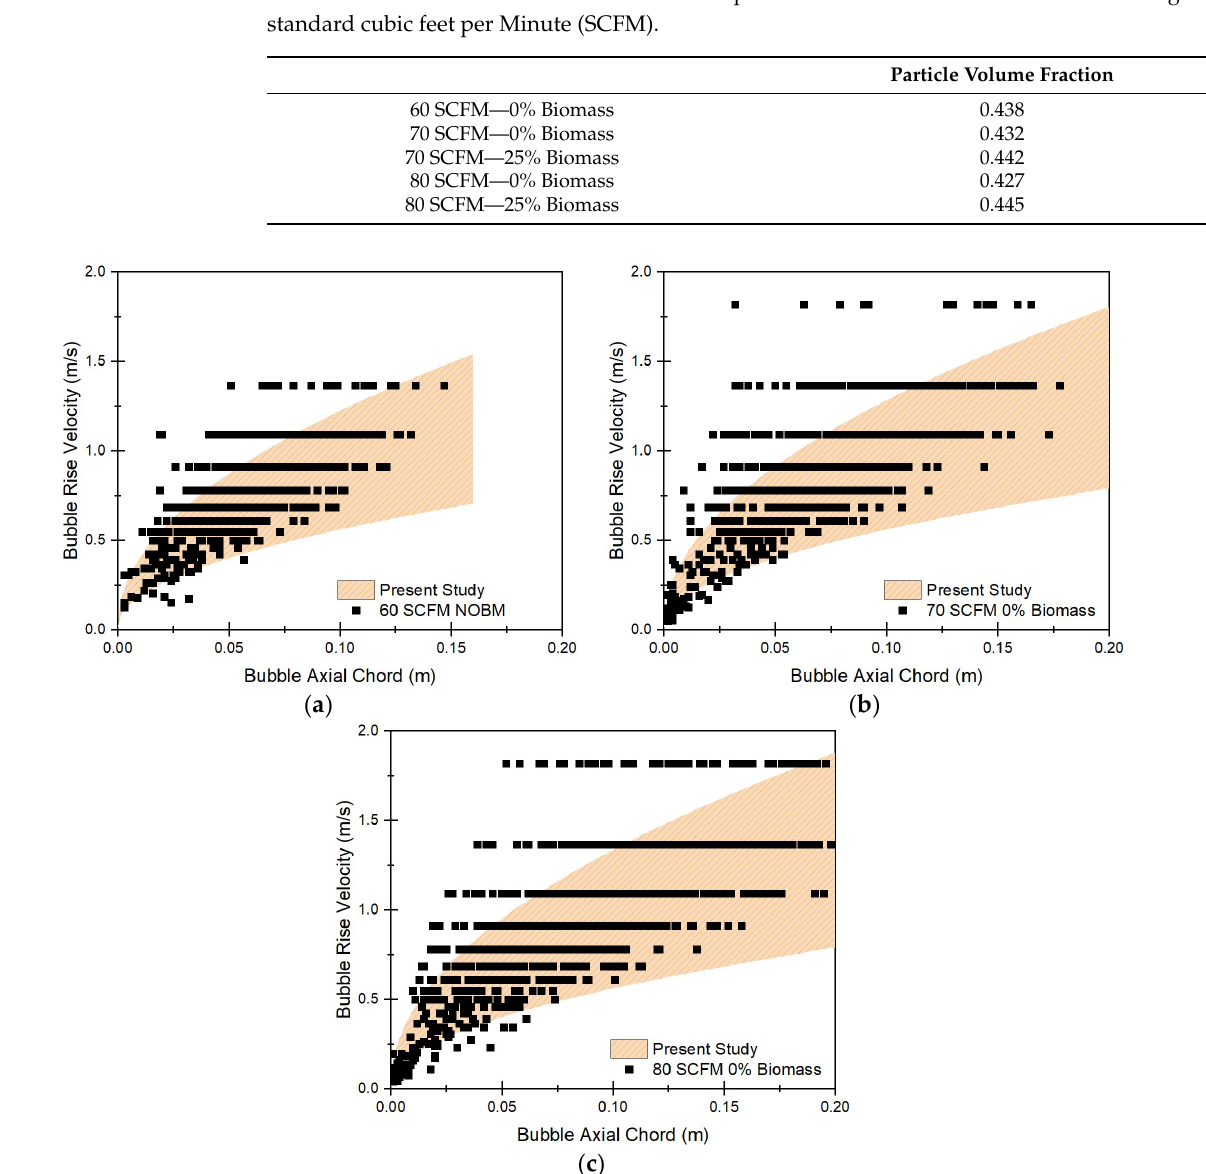
Figure 10. BRVs and BACs for bubbles measured in a bubbling regime without biomass, in a sand bed, under volumetric airflows of: ( a ) 60 SCFM; ( b ) 70 SCFM, and ( c ) 80 SCFM. Notes: (i) data points were obtained using CREC-Optiprobes and the proposed HSCE model [19]; (ii) the probabilistic predictive model (PPM) is reported with an orange band.